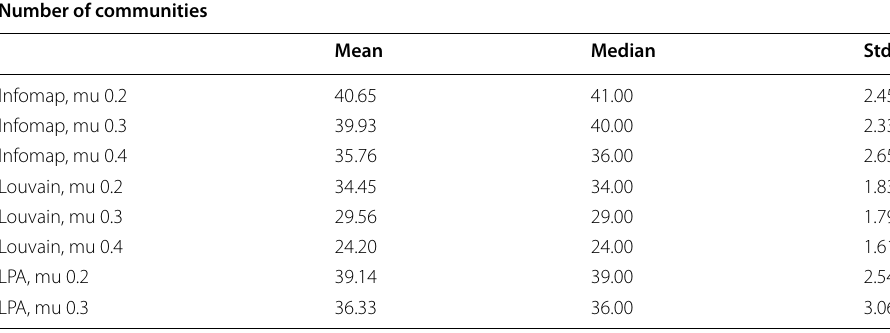
The mean, median and standard deviation are calculated across all 120 graphs in each case